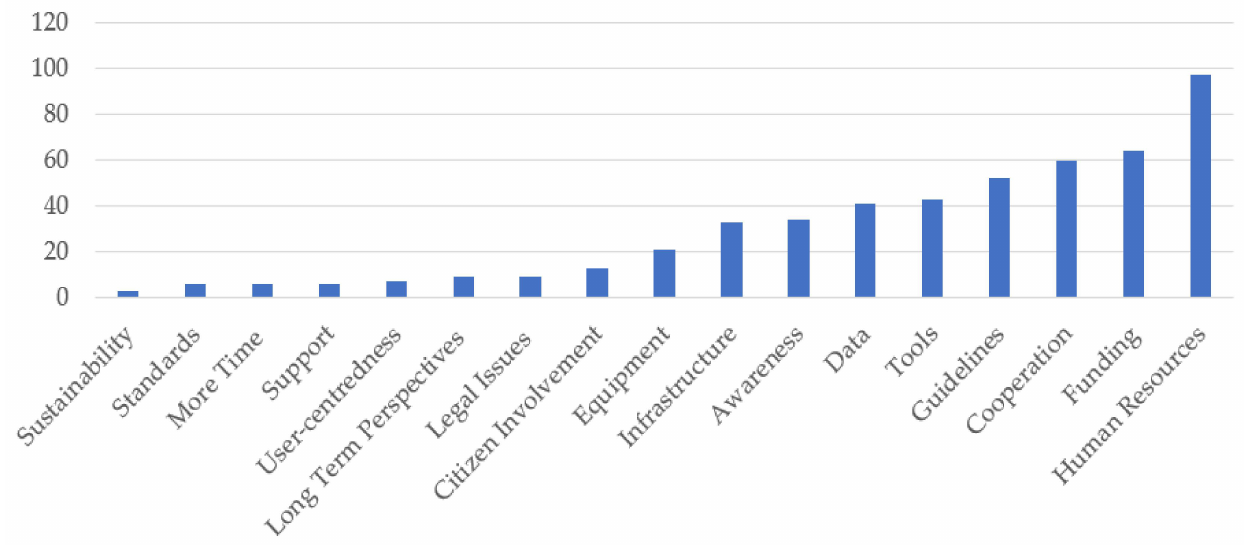
Figure 11. What would support further development? (Online survey, n = 560 named items, con- ducted in